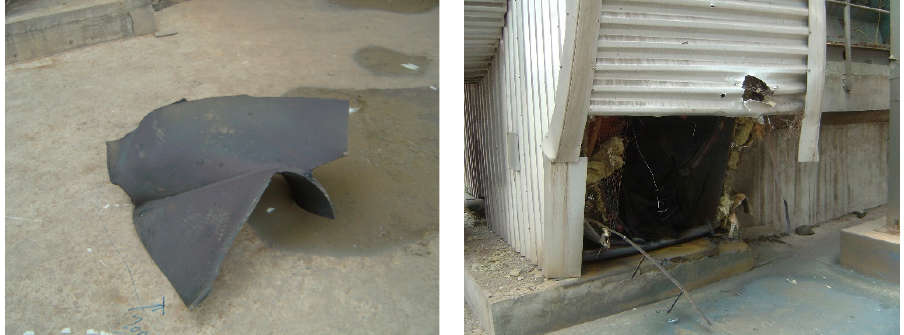
Figure 17. Photograph of destroyed housing of the BFG booster.